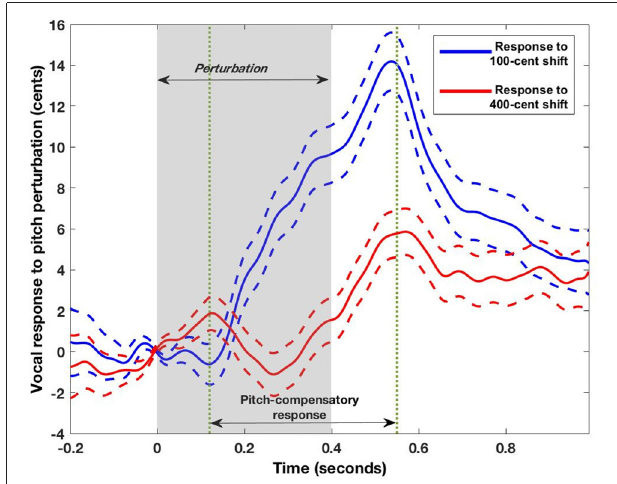
FIGURE 3 | Mean pitch perturbation response tracks ( ± 100 and ± 400) averaged across all participants ( N = 19). The positive values of both contours indicate that the average response to both upward and downward shifts was compensatory. Participants began responding to the applied perturbation at an average of 120 ms after perturbation onset and peak response was attained at an average of 550 ms after perturbation. Dashed lines represent the standard error of the corrective responses across all trials and participants.